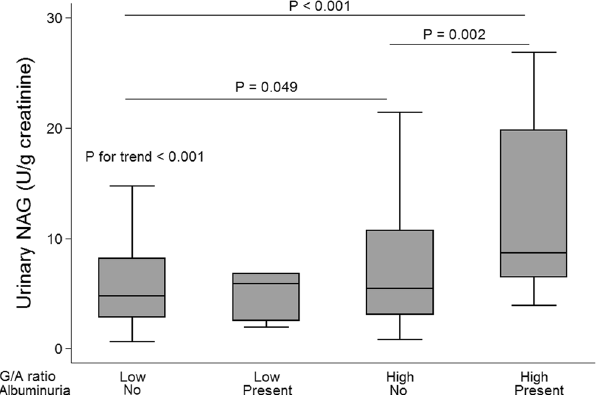
Figure 1. Comparison of uNAG level by combining the glycoalbumin-to-hemoglobin A1c (G/A) ratio and presence of albuminuria in subjects with type 1 diabetes. Low G/A ratios are indicated by values less than 2.8, whereas G/A ratios equal to 2.8 or more were defined as high. Albuminuria was defined as urinary albumin- to-creatinine ratio equal to or greater than 30 mg/g creatinine. P values for comparison between groups were calculated using Dunn’s procedure in order to correct for multiple comparison error. Abbreviations: uNAG, urinary N-acetyl- β -D-glucosaminidase; G/A ratio, glycoalbumin-to-hemoglobin A1c ratio.